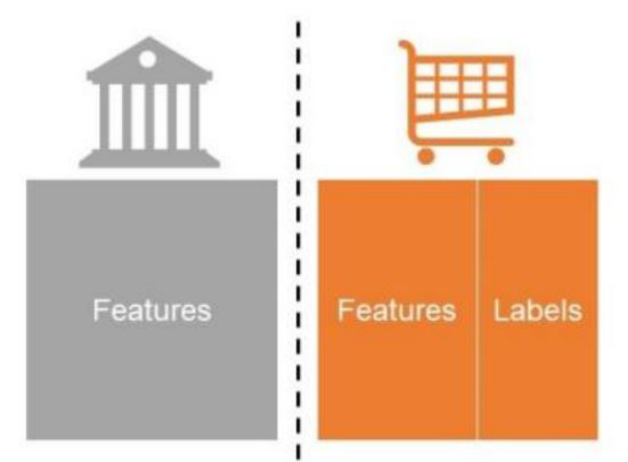
Figure 4. Vertical FL